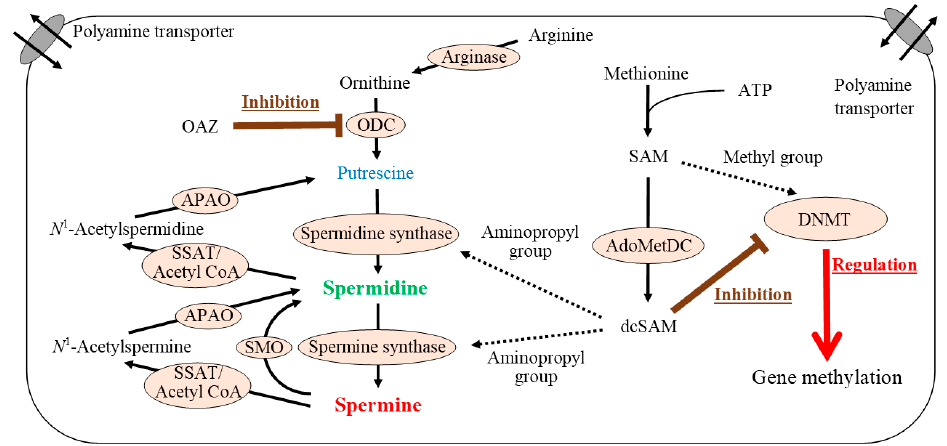
Figure 1. Polyamine synthesis and gene methylation. Ornithine produced from arginine is converted to putrescine by the action of ornithine decarboxylase (ODC), a rate-limiting enzyme in polyamine synthesis. Spermidine is synthesized by addition of an aminopropyl group supplied from decarboxylated S-adenosylmethionine (dcSAM) via the action of spermidine synthase. A second aminopropyl group can be added to spermidine by spermine synthase to produce spermine. When spermine is supplied from extracellular sources as a result of increased polyamine intake, spermidine is produced by the degradation of spermine via spermidine/spermine N 1 -acetyltransferase (SSAT)/acetyl coenzyme A (acetyl CoA) and N 1 -acetylpolyamine oxidase (APAO). dcSAM is synthesized from SAM by enzymatic activity of S-adenosylmethionine decarboxylase (AdoMetDC). SAM is synthesized from methionine and adenosine, and serves as a methyl-group donor in vivo. dcSAM concentrations have an inverse association with DNMT activity. AdoMetDC: S-adenosylmethionine decarboxylase, APAO: N 1 - adenosylmethionine, DNMT: DNA methyltransferase, OAZ: ODC antizyme-1, ODC: ornithine decarboxylase, SAM: S-adenosylmethionine, SMO: spermine oxidase, SSAT: